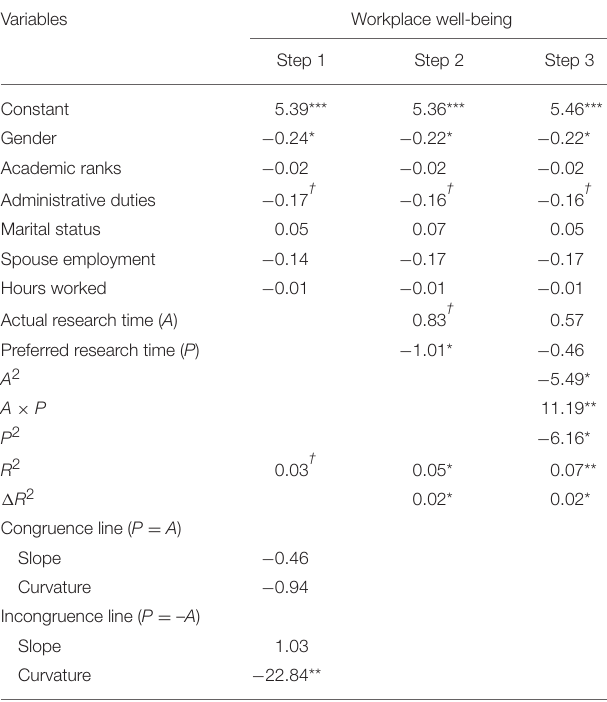
TABLE 4 | Polynomial regressions of workplace well-being on research time